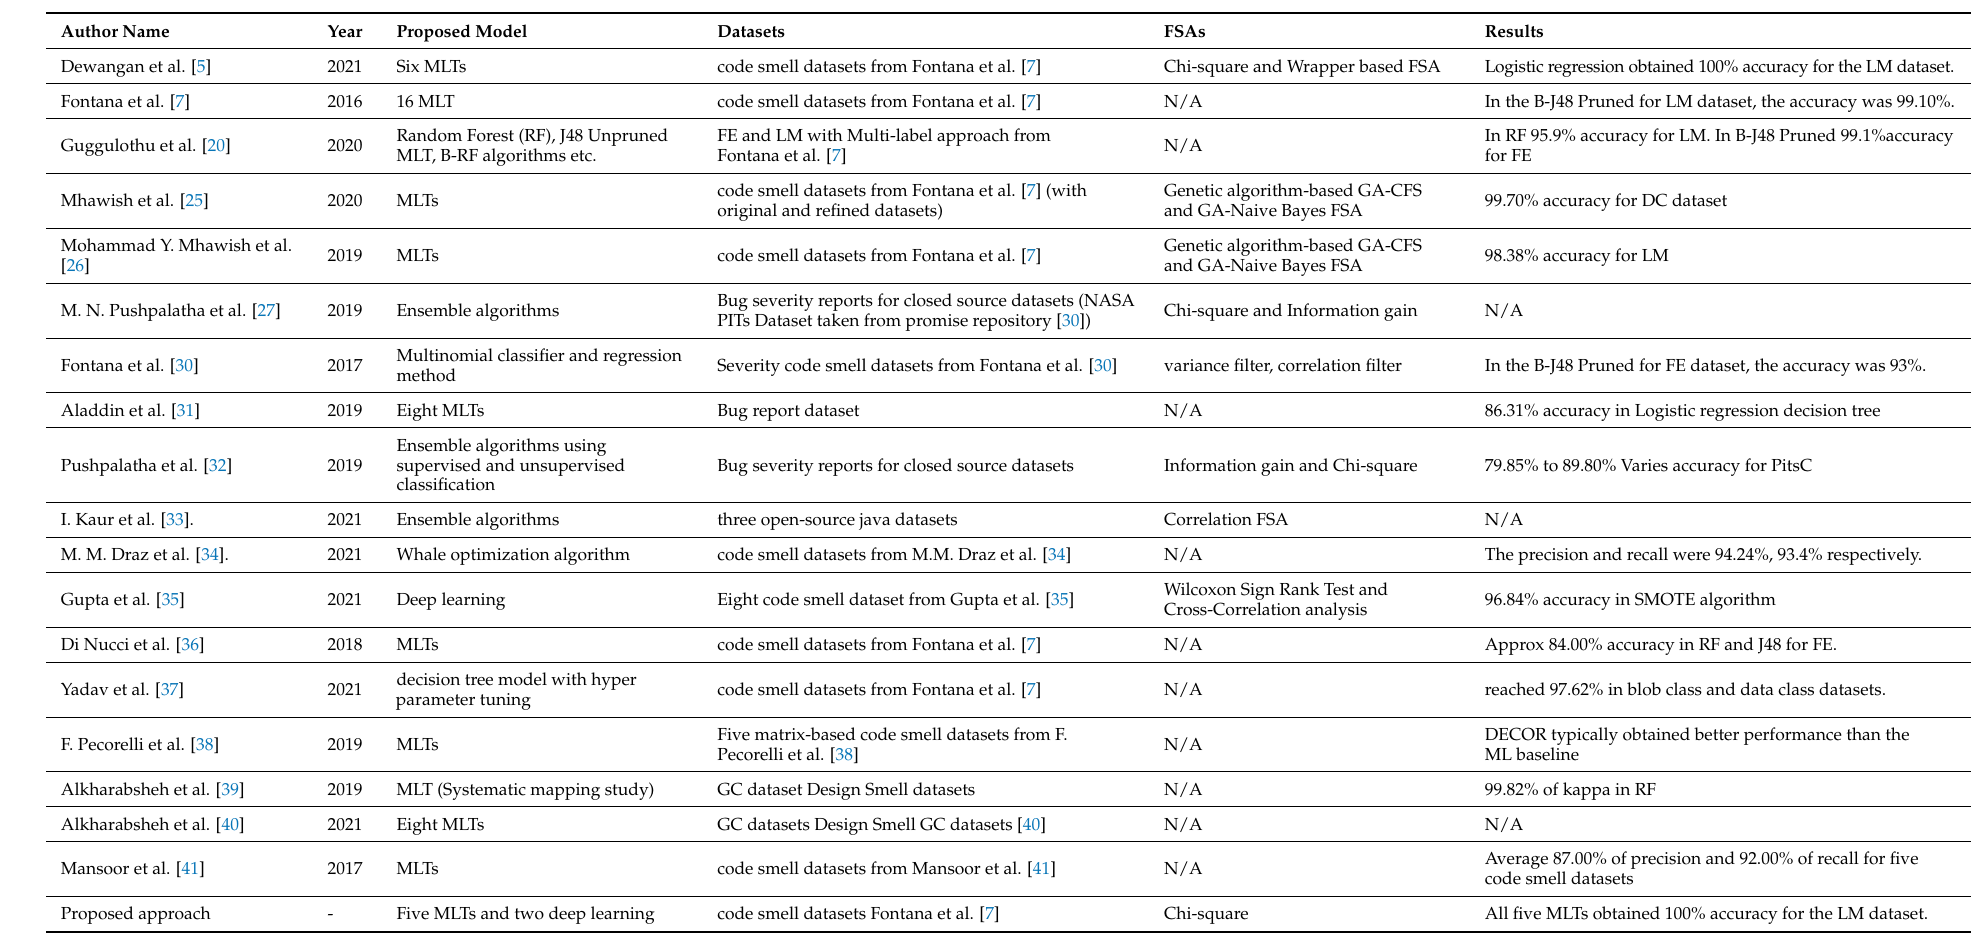
Table 1. Previous work on code smells